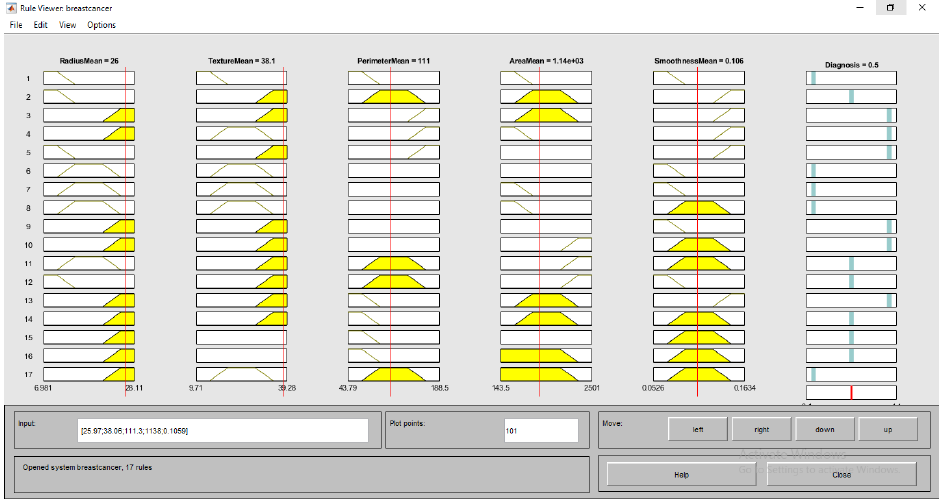
Figure 24. Diagnosis for mild cases.